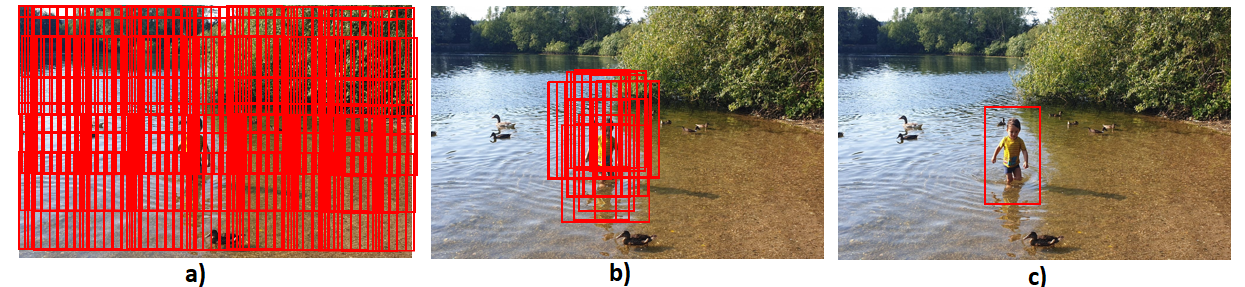
Figure 6. ( a ) Sliding window approach densely applied in all location of the image. ( b ) Only the bbox that have 50% of overlap with the object (child) are used by the regression algorithm to predict the final bbox. ( c ) Predicted bbox are drawn around the object